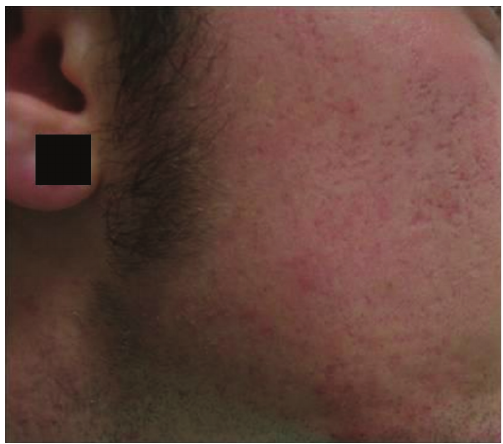
Figure 8: Needling: patient after the